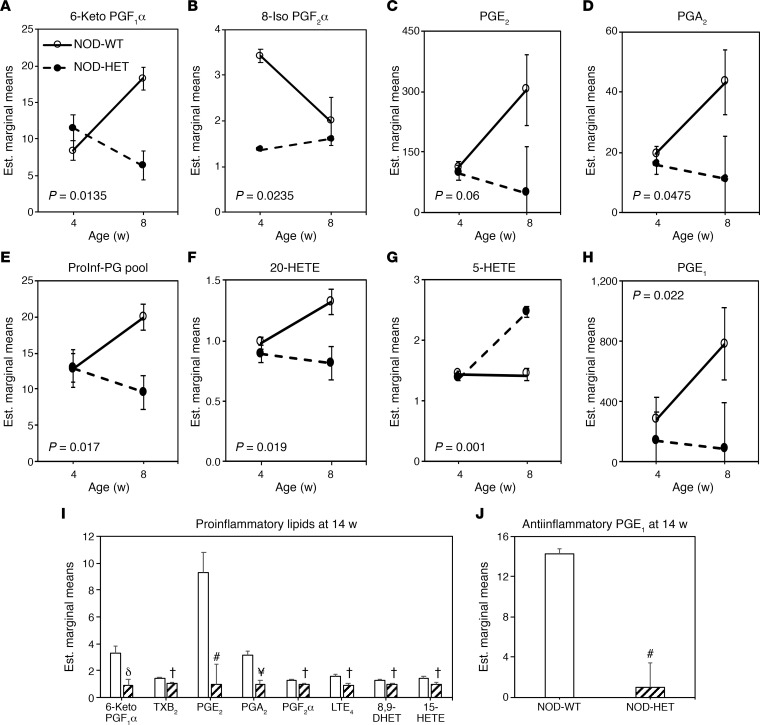
Comparison of eicosanoid production by MΦNOD and MΦNOD-HET.Peritoneal MΦ isolated from female NOD and NOD-HET mice were treated with vehicle control (DMSO) or classically activated with IFN-γ + LPS, and the media was collected for eicosanoid analyses at 16 hours. The data (estimated marginal mean ± SEM) represent fold-change in activated lipids, relative to corresponding control. MΦNOD (n = 9 and 5) and MΦNOD-HET (n = 4 and 3) at 4 and 8 weeks, respectively. (A) 6-Keto PGF1α. (B) 8-Iso PGF2α. (C) PGE2. (D) PGA2. (E) Proinflammatory prostaglandin (PG) pool. (F) 20-HETE. (G) 5-HETE. (H) PGE1. (I and J) Proinflammatory (I) and antiinflammatory PGE1 (J) at 14 weeks. NOD-HET significantly different from NOD, †P < 0.05; δP < 0.01; #P < 0.005; ¥P < 0.001, n = 9 in each group. Statistical analyses: (A–H) multivariate 2-way ANOVA and time-course ANOVA; (I and J) Student’s t test.